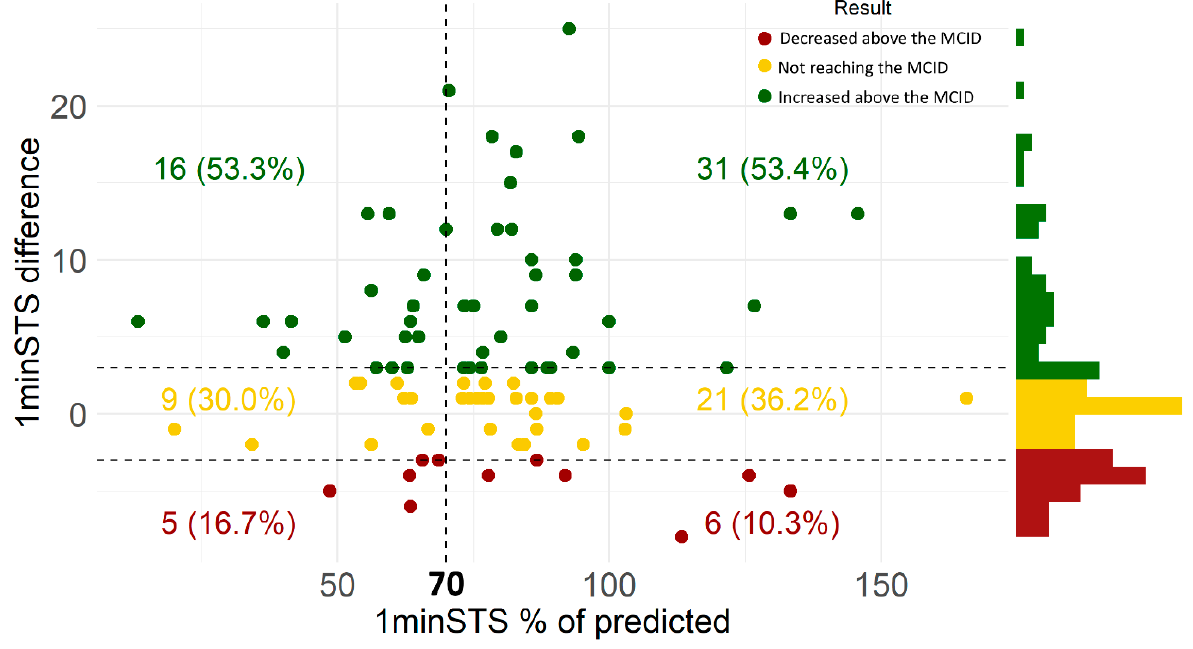
Figure 3. Change in the one-minute sit-to-stand (1minSTS) number of repetitions from the first to the sixth assessment in participants with baseline functional status impairment (i.e., 1minSTS <70% predicted—represented as dots in the left side of the vertical dashed line) or without impairment (i.e., 1minSTS ≥ 70% predicted—represented as dots in the right side of the vertical dashed line).The vertical dashed line illustrates the established impairment cut-off; horizontal dashed lines illustrate the minimal clinically important differences interval (MCID): ±3 repetitions; green dots represent participants who had their number of repetitions increased above the MCID; yellow dots represent participants who had their number of repetitions similar or unchanged with time without reaching the MCID; red dots represent participants who had their number of repetitions decreased above the MCID.